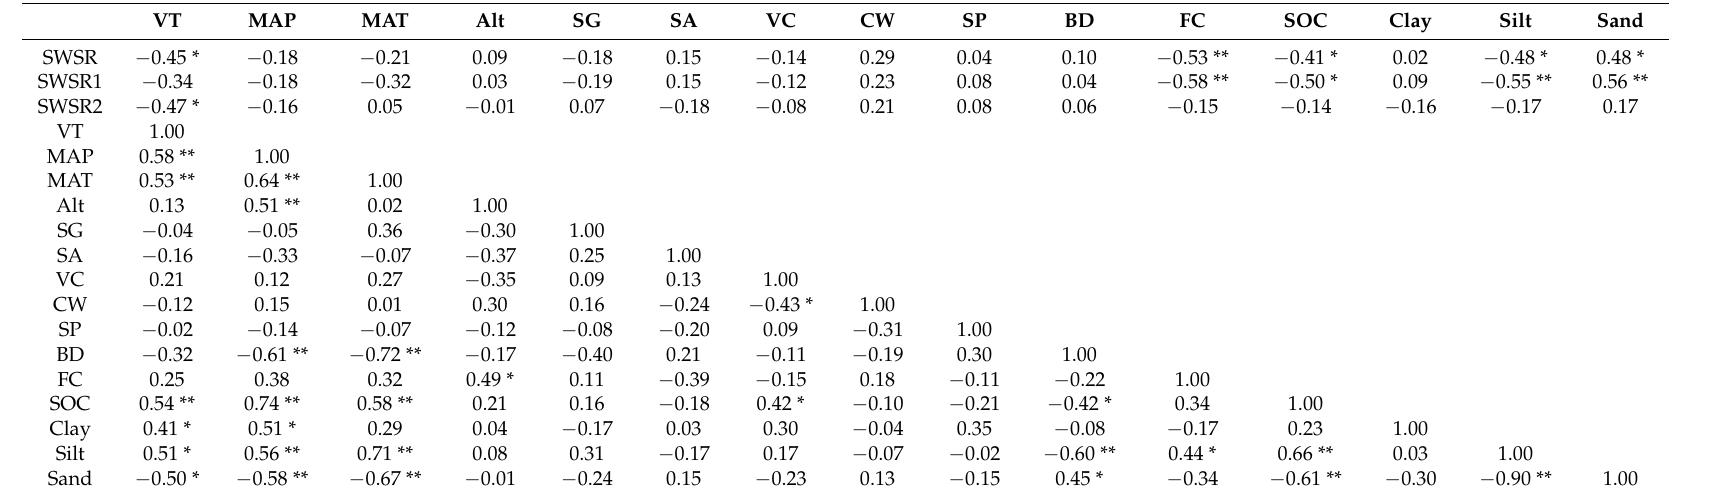
Table 2. Pearson correlation coefficients between the SWSR and influencing